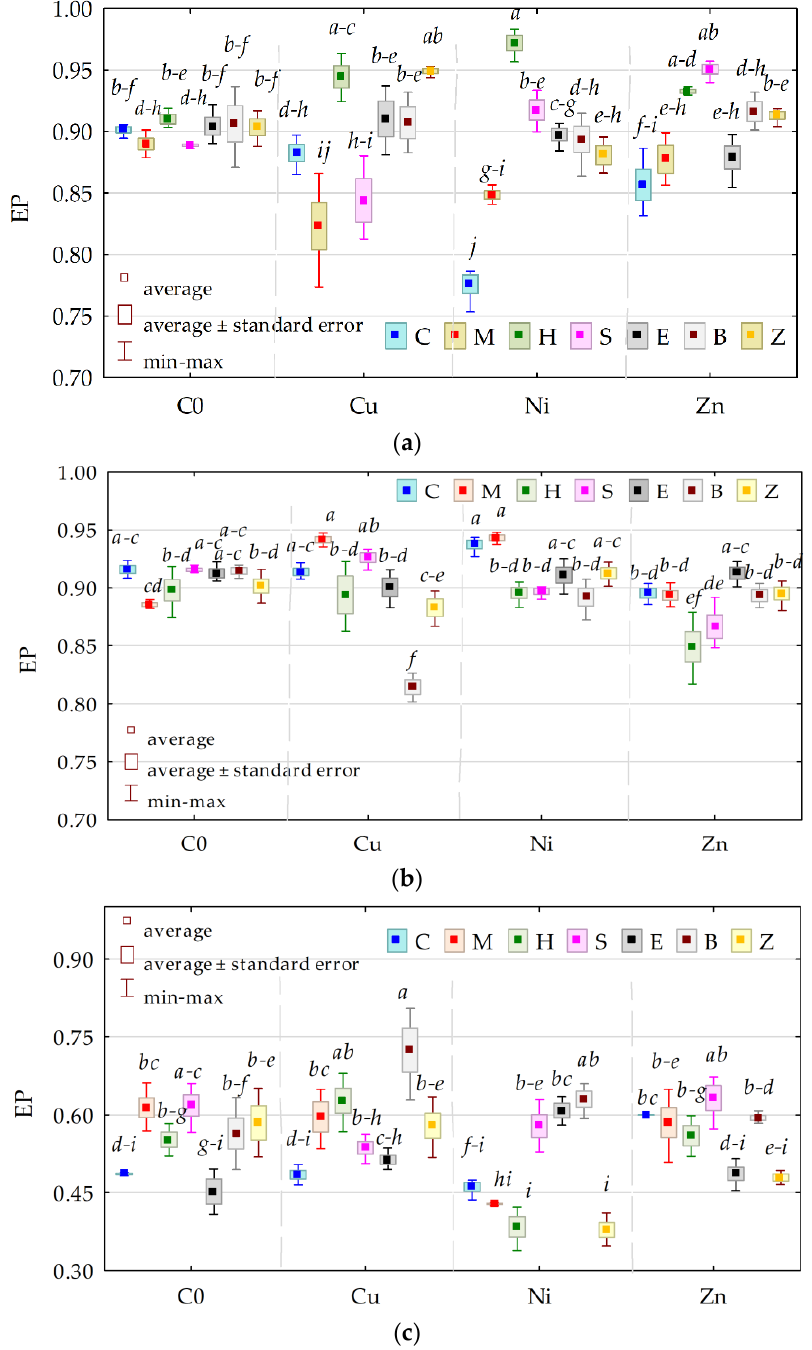
Figure 3. Ecophysiological diversity index (EP) ( a ) organotrophic bacteria, ( b ) actinomycetes, and ( c ) fungi. Homogeneous groups were calculated for EP values determined for all sorbents (denoted with letters a-i). The abbreviations are explained under Figure 2.